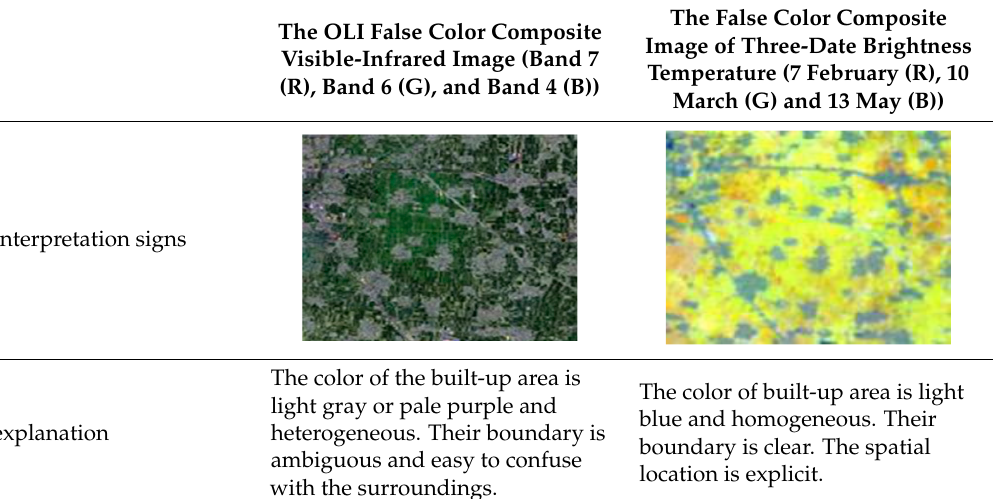
ambiguous and easy to confuse with the surroundings.